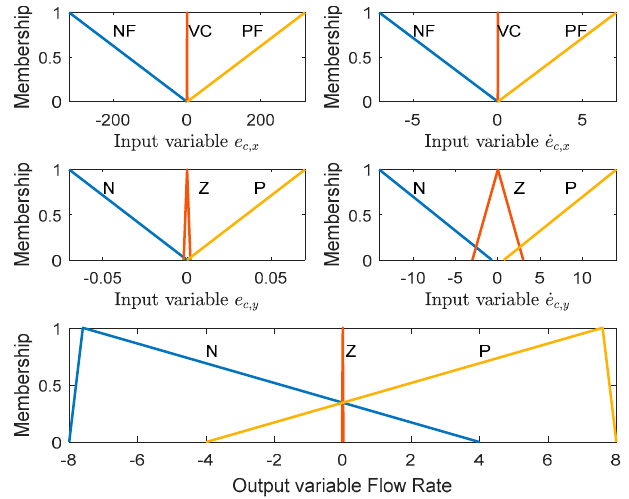
Figure 6 . Fuzzy logic membership functions for the inputs and outputs of steering angle .